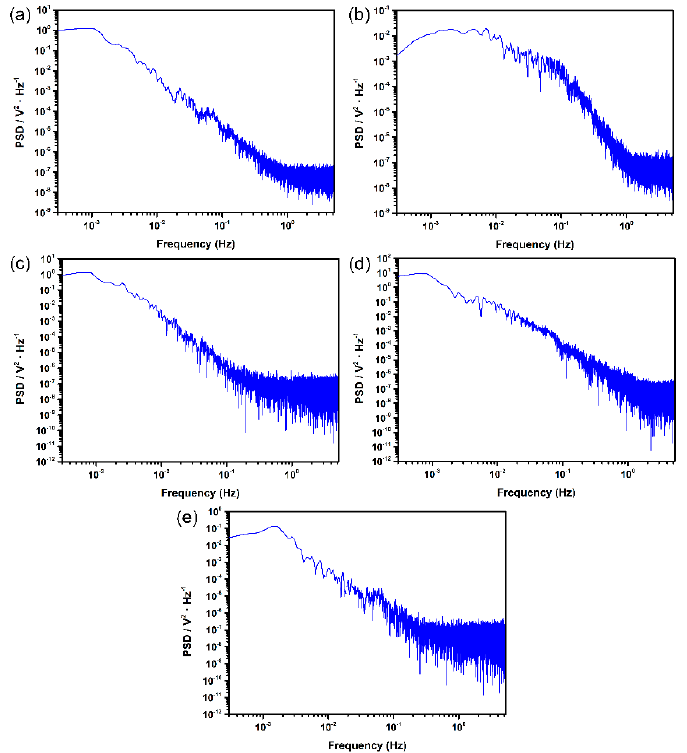
Figure 6. Potential PSD plots for different surface roughness samples of DSS 2205 in 10% FeCl 3 at 50 °C: ( a ) 180#; ( b ) 600#; ( c ) 1000#; ( d ) 2000#; ( e ) polished.